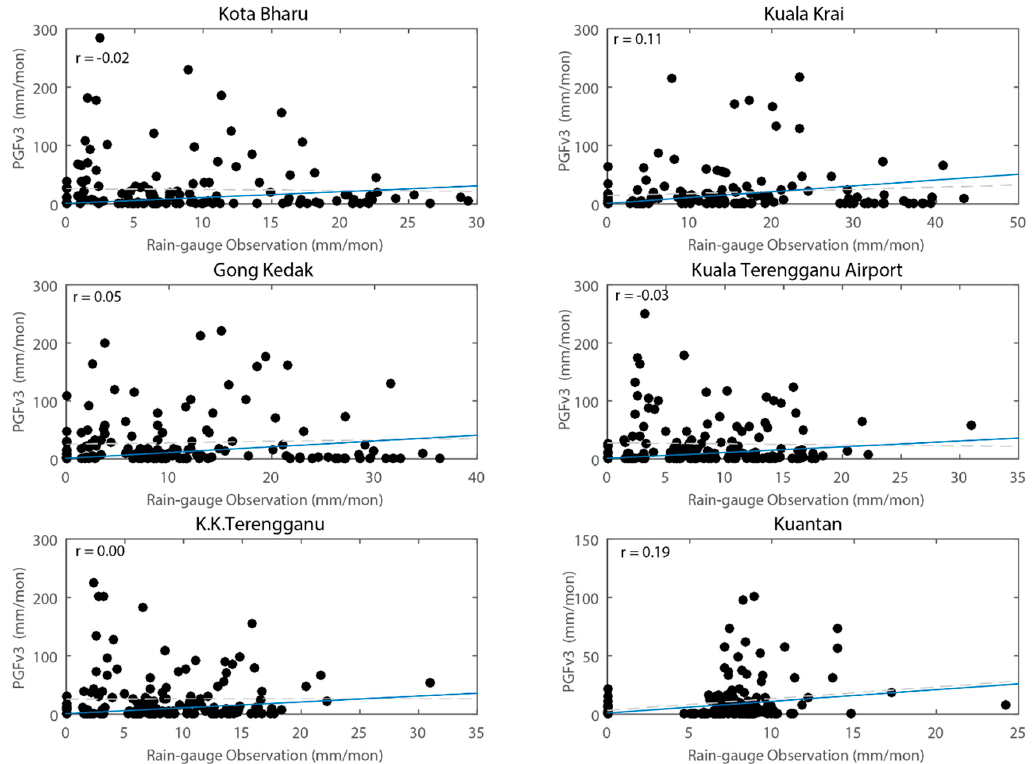
Figure 10. Scatter plot of PGFv3 for six rain gauge locations in East Peninsular Malaysia (EPM) on November.